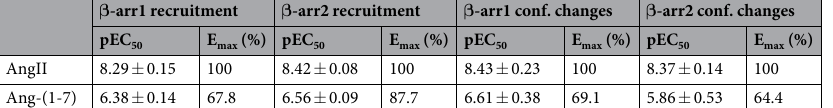
Table 2. Potencies (pEC 50 ) and efficacies (E max ) of AngII and Ang-(1-7) in promoting β -arrestin 1 and β -arrestin 2 recruitment and conformational changes. EC independent experiments. E max values for Ang-(1-7) are shown as a percentage of the maximum values obtained for